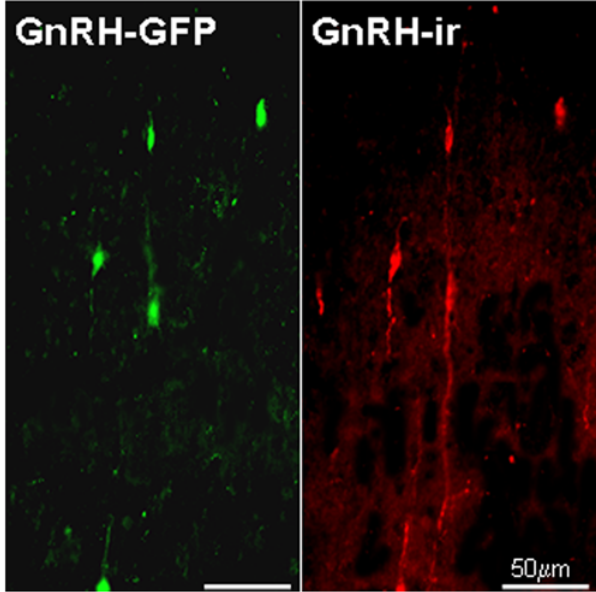
Figure 1. Confocal microscopy revealing GFP-expressing GnRH neurons (left) and immunostaining with LR1 (right). Note that the two techniques reveal a similar number of GnRH perikarya, but the extent of the neurites is clearer using the immunohistochemical approach. Scale bars=50 m m.